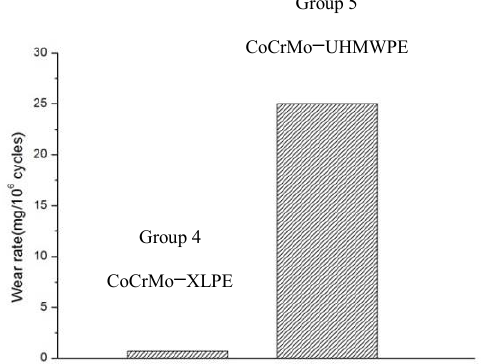
Figure 5. Wear rate for Group 4 and Group 5.